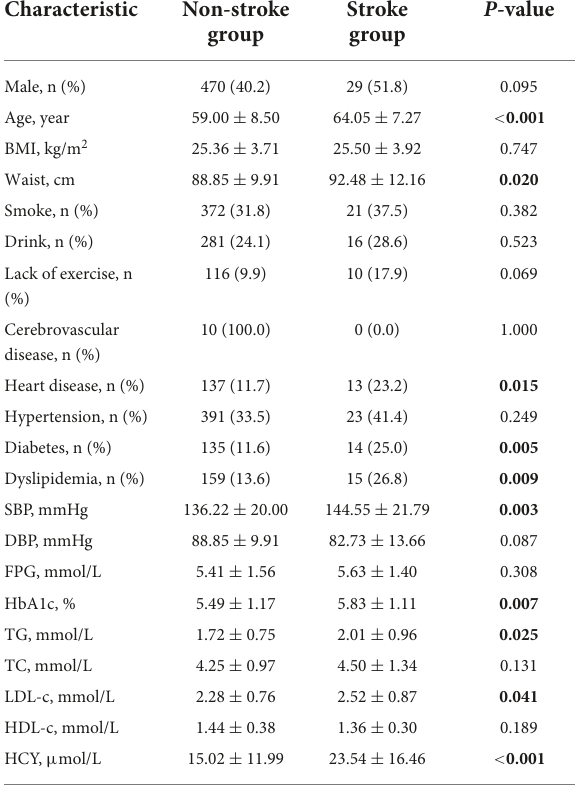
TABLE 1 Characteristics between the two groups with or without occurrence and